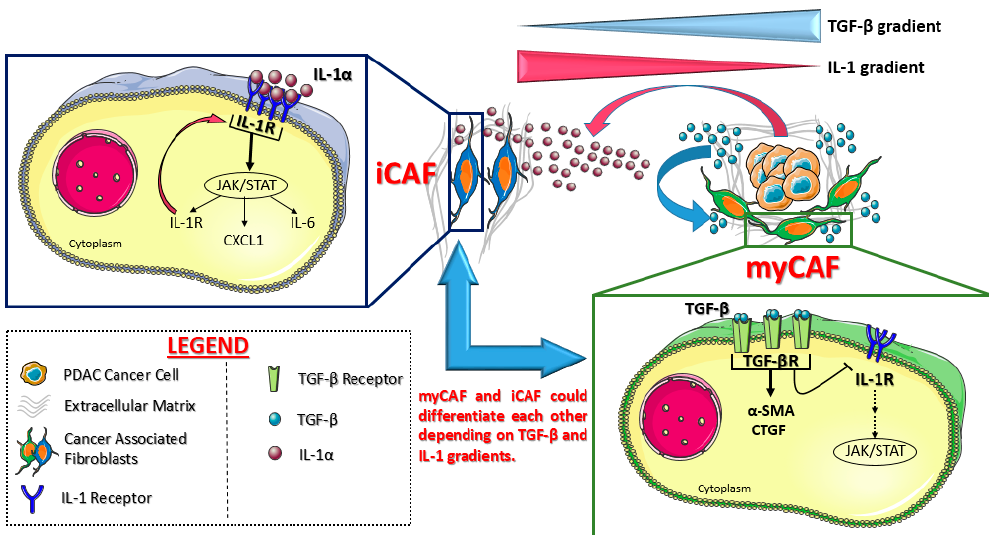
Figure 2. Cancer-associated fibroblast (CAF) subtypes identified in pancreatic cancer by Öhlund D et